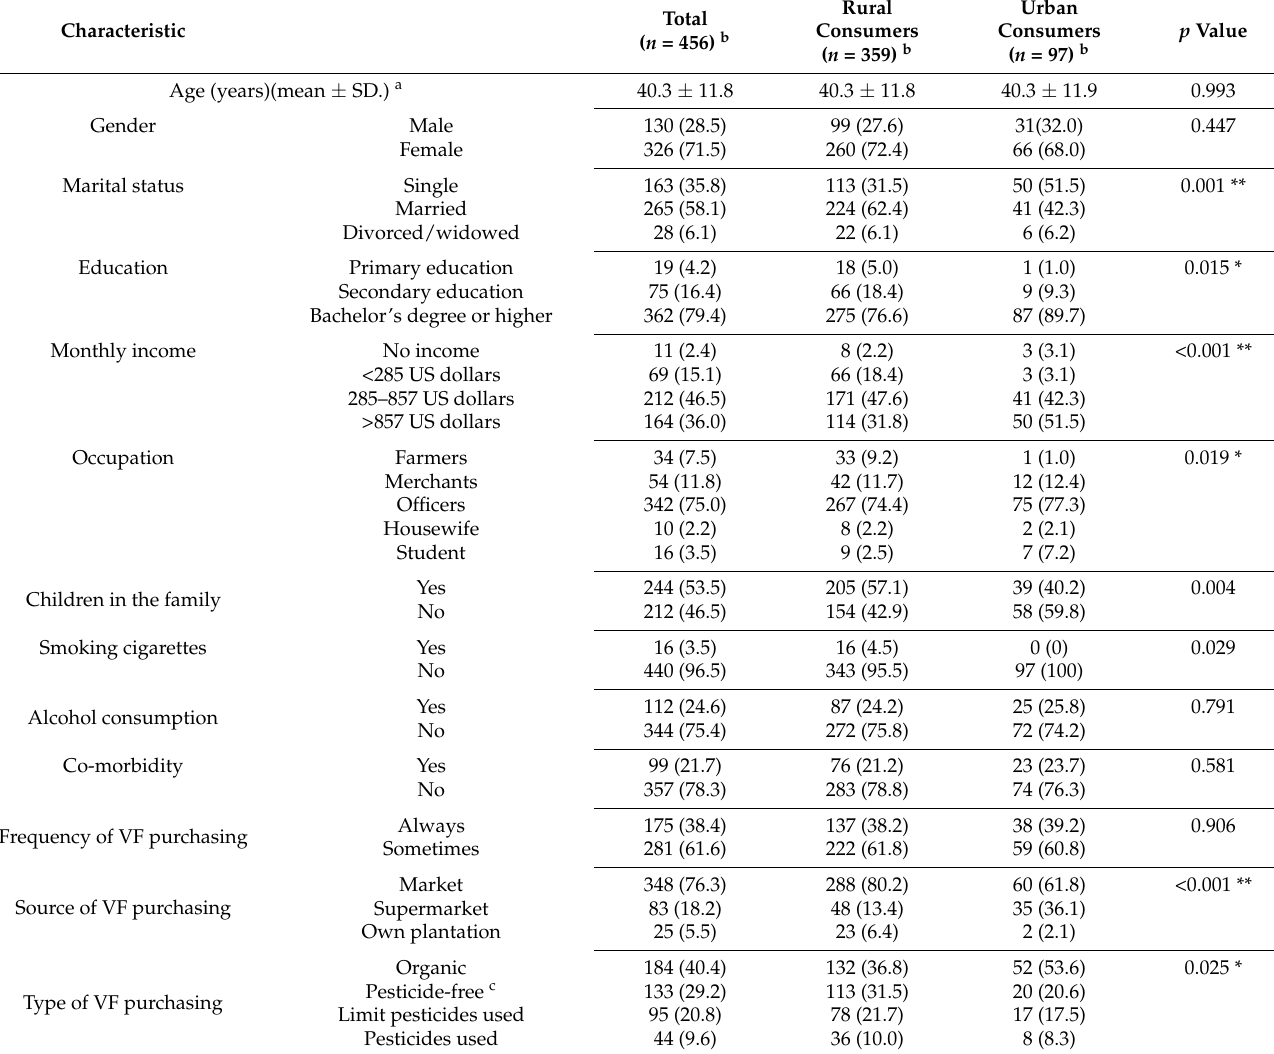
Table 1. Demographic characteristics and habits of VF consumption of